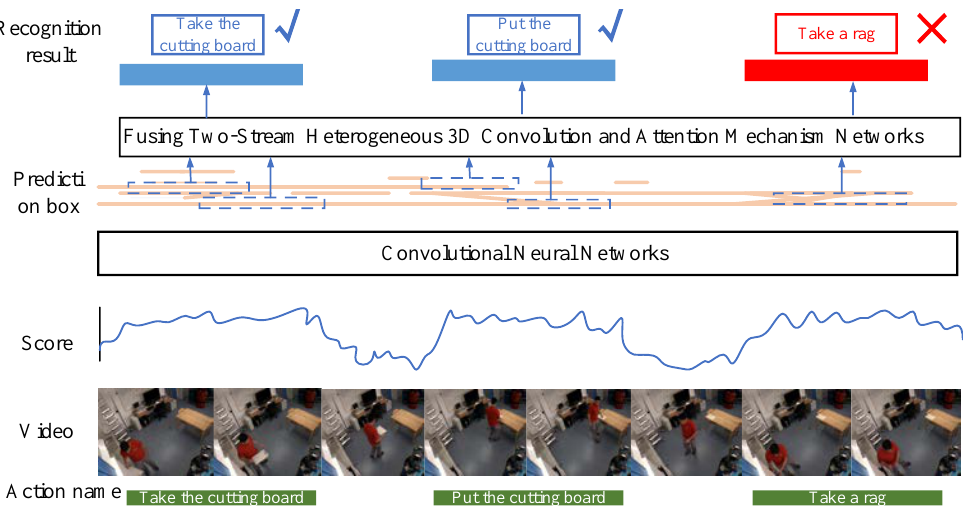
Figure 3. Action location and recognition.